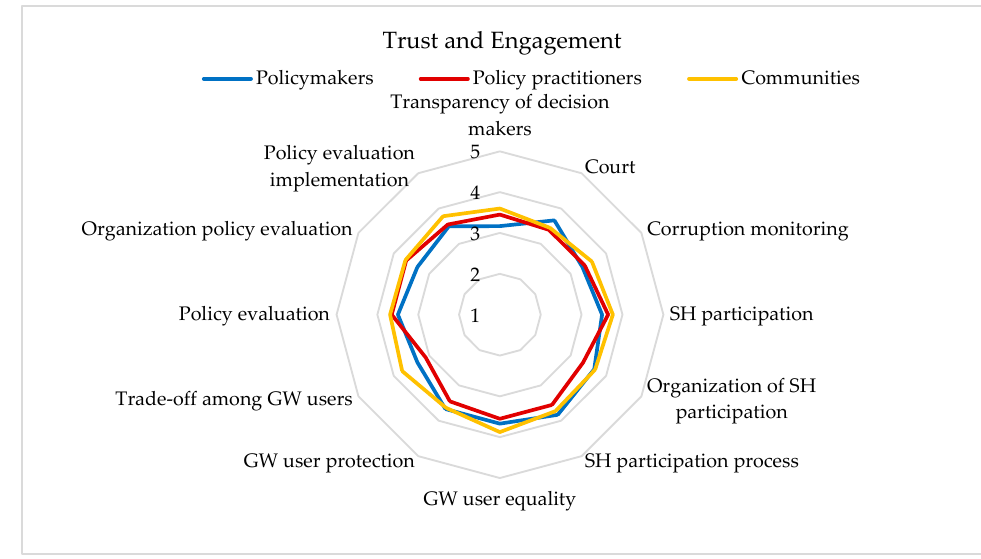
Figure 7. Trust and engagement dimension of groundwater governance.